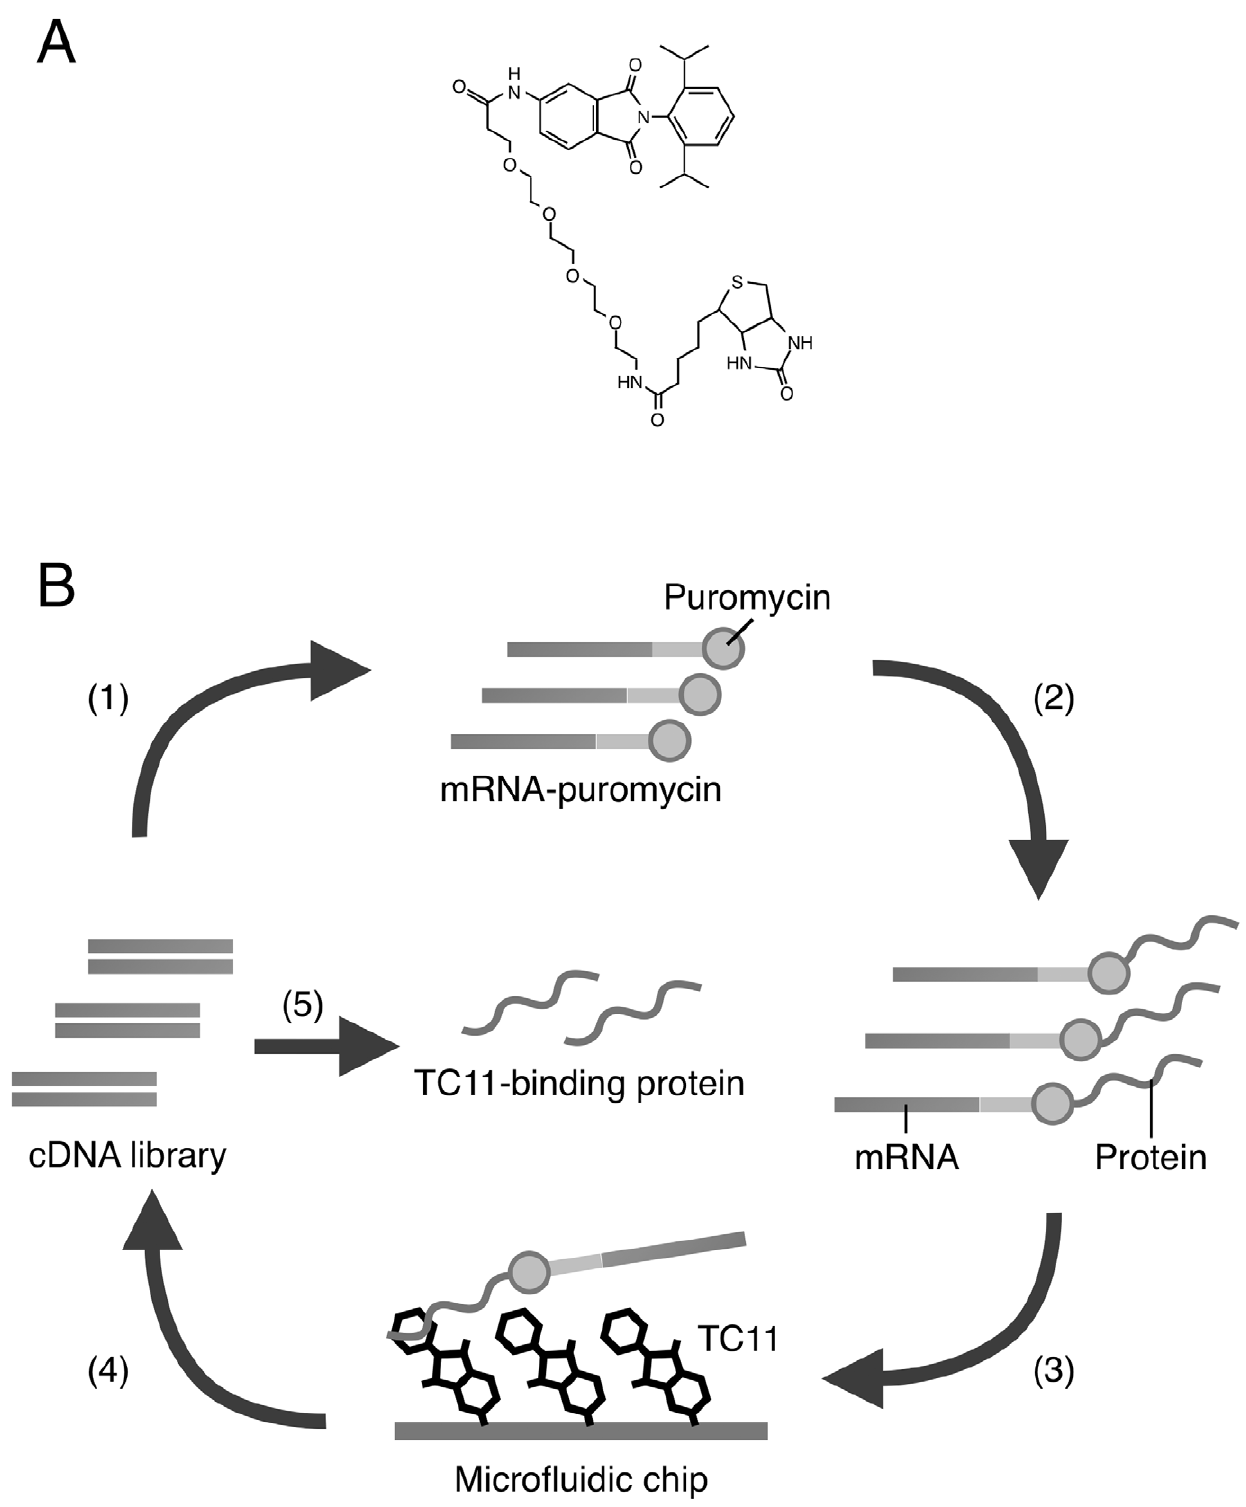
Figure 4. Schematic representation of invitro selection of TC11-binding protein using mRNA display. (A) The chemical structure of biotinylated TC11. (B) A cDNA library derived from KMS34 cells was transcribed, ligated with PEG-Puro spacer (1) and in vitro translated (2) to form a protein-mRNA conjugates library. The library is injected into micro fluidic chip on which TC11 is immobilized (3) and unbound molecules were washed away. The bound molecules were eluted and their mRNA portion is amplified by RT-PCR (4). The resulted DNA can be used for the next of round and analyzed by cloning and sequencing. (See also Materials and Methods.).